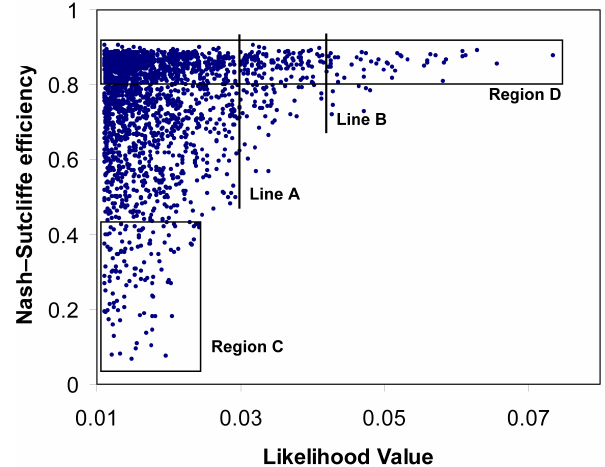
Fig. 9. Likelihood versus Nash-Sutcliffe efficiency of simulated dis- charge for parameter sets with associated likelihood values higher than